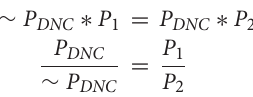
from a neuron are equal.